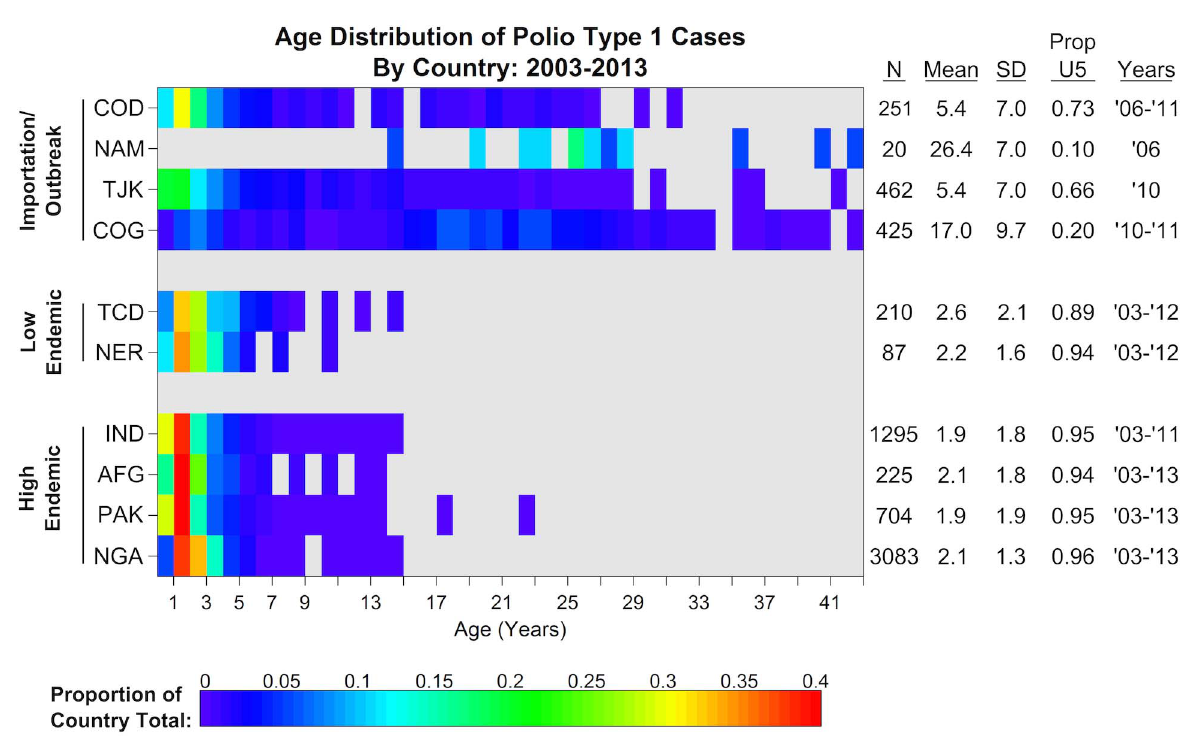
Figure 5. Distribution of cases by age (in years) during previous polio outbreaks for endemic and previously polio-free countries. The number of confirmed type 1 cases, mean age of infection, standard deviation of infection age, proportion of cases under five years old, and duration of case data used are in the table to right. High endemic countries are those that have sustained continuous transmission: India (IND), Afghanistan (AFG), Pakistan (PAK), and Nigeria (NGA). Low endemic areas are those that are exposed periodically to virus due to regular importations: Chad (TCD) and Niger (NER). Importation countries are those that have not reported WPV transmission since at least 2000: Democratic Republic of Congo (COD), Namibia (NAM), Tajikistan (TJK), and Republic of Congo (COG). Information compiled from multiple AFP databases maintained by WHO HQ, regional and country offices.